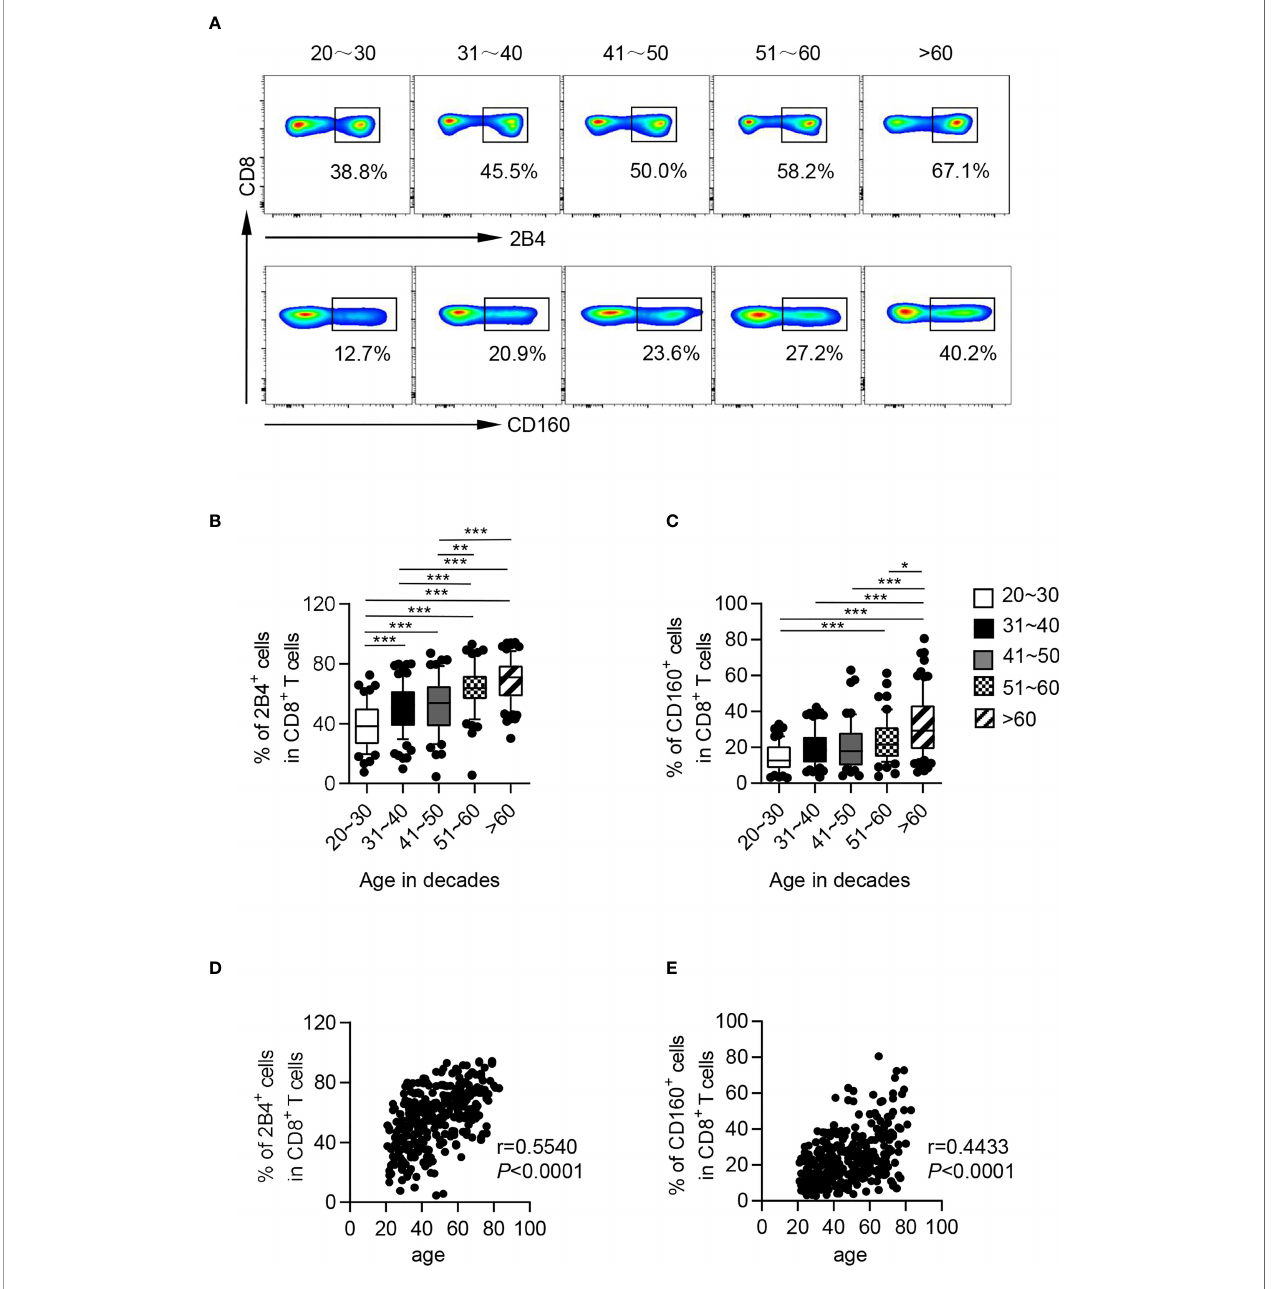
FIGURE 1 | CD244 and CD160 on CD8 + T cells from healthy individuals were upregulated with age. Flow cytometry analysis of CD244 and CD160 expression was performed on PBMCs collected from healthy individuals of different ages. (A) Representative fl ow data show the expression of CD244 (up) and CD160 (down) gated on CD8 + T cells from fi ve healthy individuals in different age groups. (B, C) Box plots of the percentage of CD244 + and CD160 + cells on CD8 + T cells from healthy individuals in different age groups (n = 52-84 each group). P values were obtained by one-way ANOVA followed by Tukey ’ s multiple comparisons test [CD244 (left)] or Kruskal-Wallis test followed by Dunn ’ s multiple comparisons test [CD160 (right)]. (D, E) Correlation analysis of age and CD244 (D) , CD160 (E) expression on CD8 + T cells from all healthy individuals. Spearman ’ s non-parametric test was used to test for correlations. * P < 0.05, ** P < 0.01, *** P <